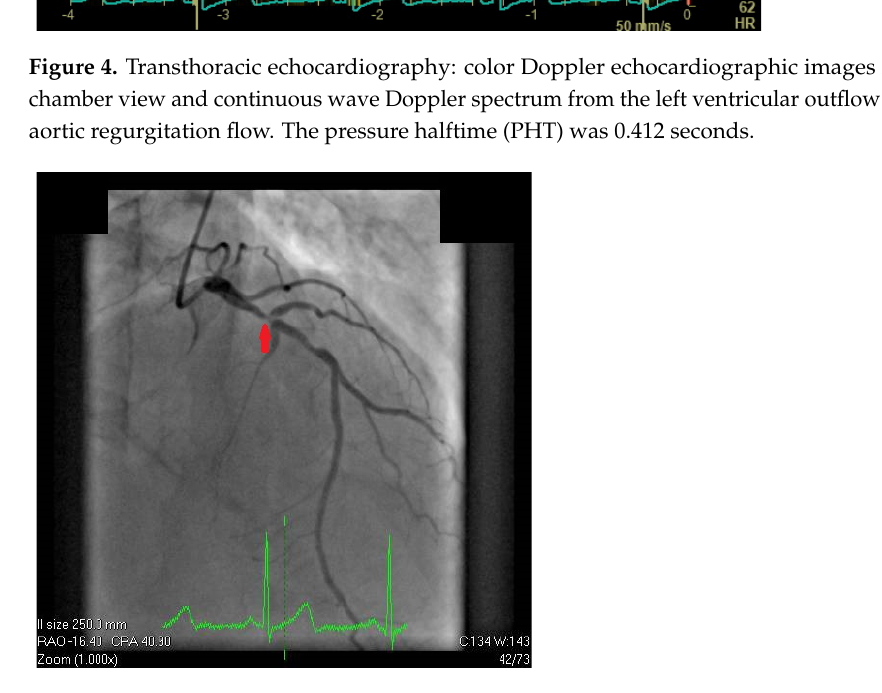
Figure 5. Coronary angiography. Cranial projection of the left coronary artery revealed significant calcified lesion in the proximal left anterior descending artery involving the principal diagonal branch (Medina 1,1,1 with TIMI3 flow).